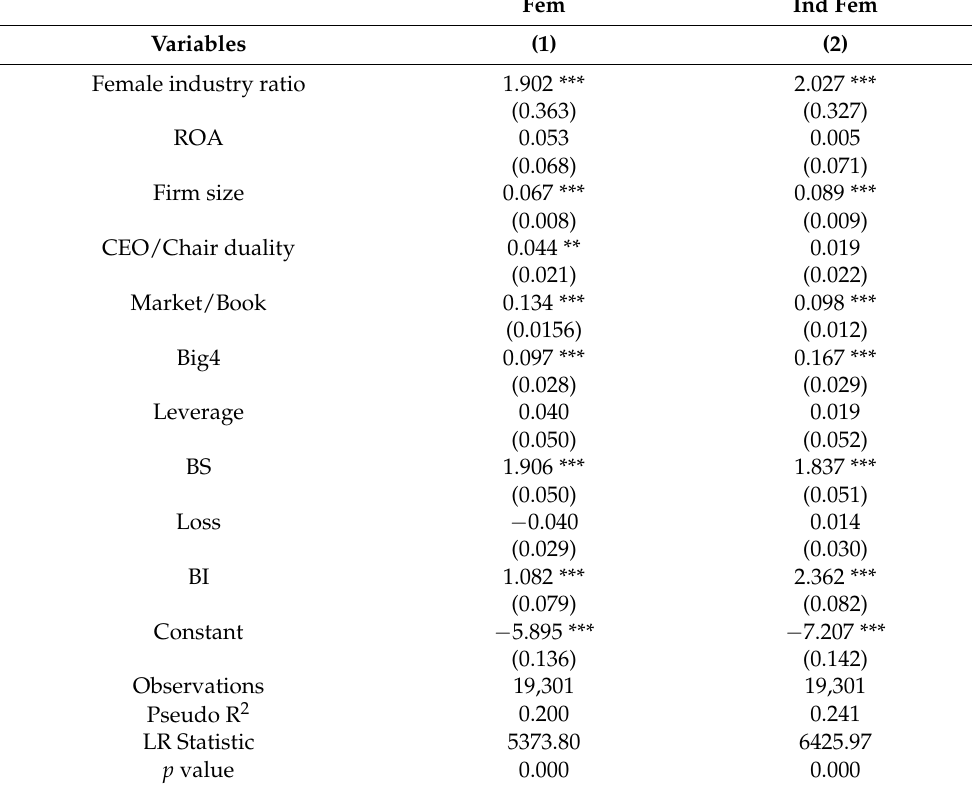
Table 9. Independent female directors and fraud. Heckman correction (first stage).